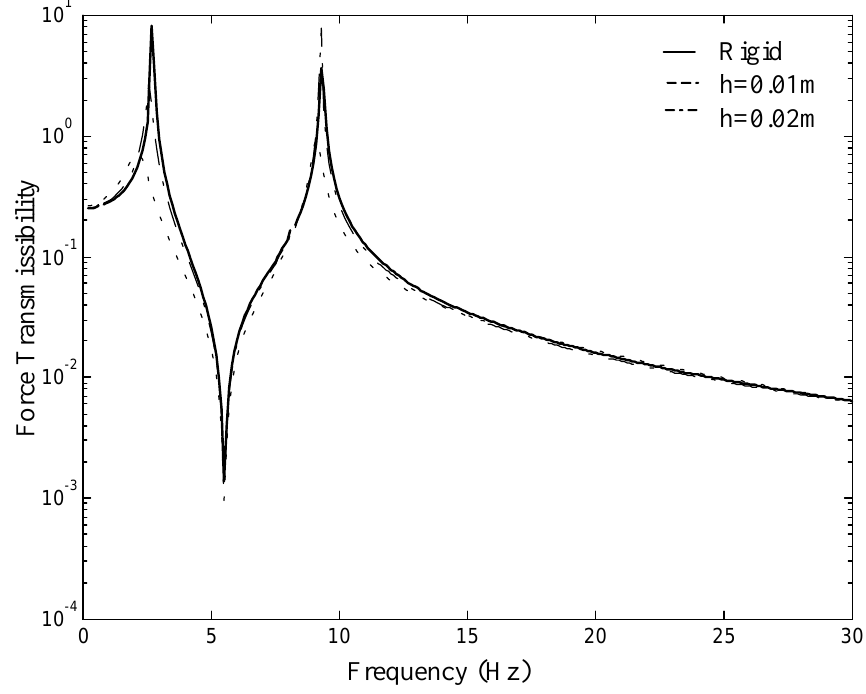
Fig. 11. Vertical force transmission at mount 1-infinite plate with heavy fluid loading under the unit moment excitation around z-axis at c.g. of rigid body. The receptance from evanescent wave and acoustic contribution is